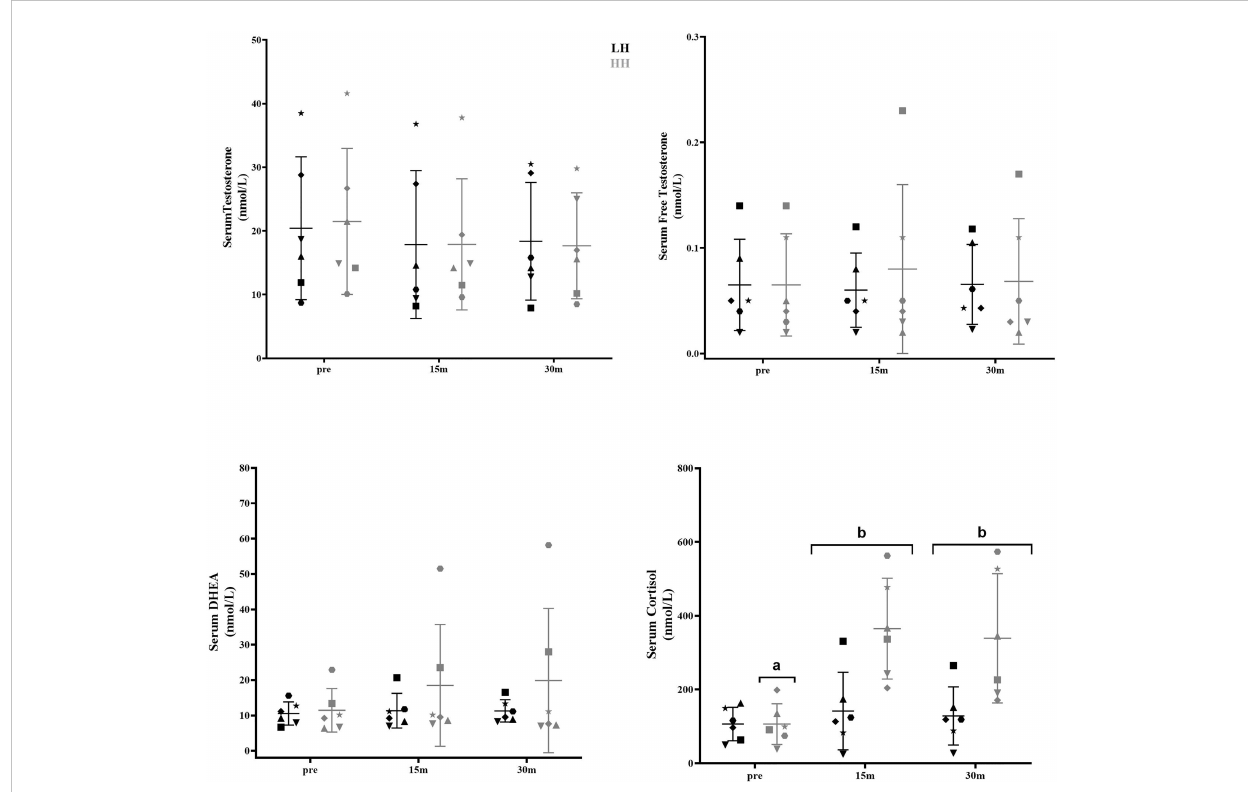
FIGURE 1 Serum steroid hormone concentrations pre-LH and HH protocols and at 15 min and 30 min postexercise. (a) Signi fi cantly different from corresponding 15-min and 30-min postexercise. (b) Signi fi cantly different from LH. Values are presented as the mean and SD. Each symbol represents one